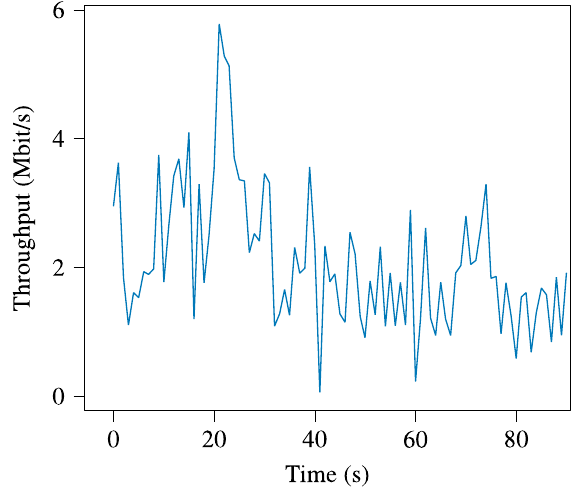
Figure 4. Service channel throughput during H7’s attack of H10.